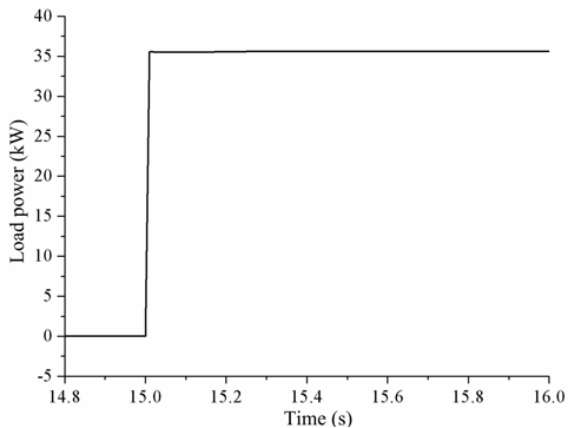
Figure 4. Load power step of the HESGS.